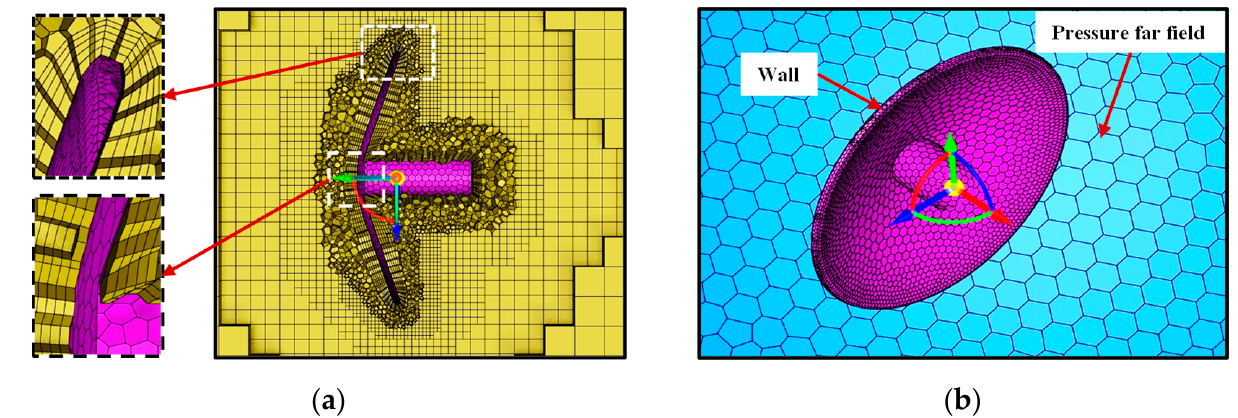
Figure 4. 3D model of reentry vehicle.